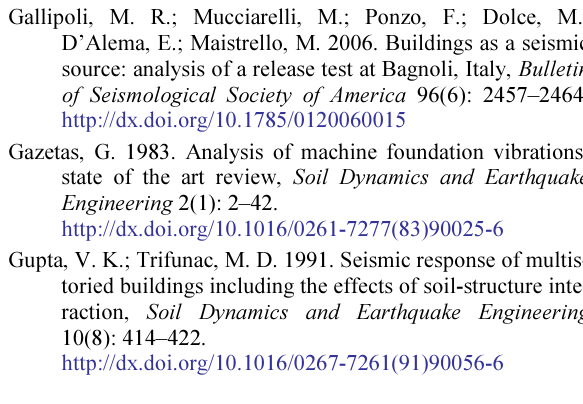
Fig. 8. Response of soil versus soil shear wave